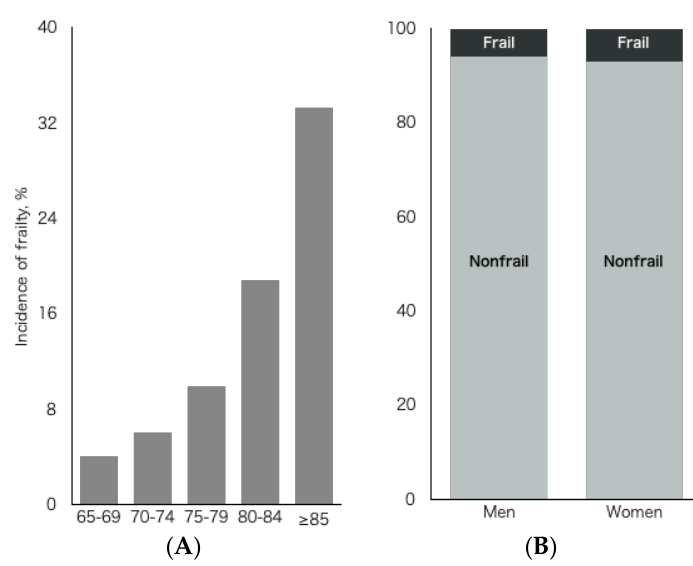
Figure 1. Incidence of frailty by age and sex during the 4-year follow-up period. ( A ) showed the incidence of frailty by age group. ( B ) showed sex-specific differences in the incidence of frailty.